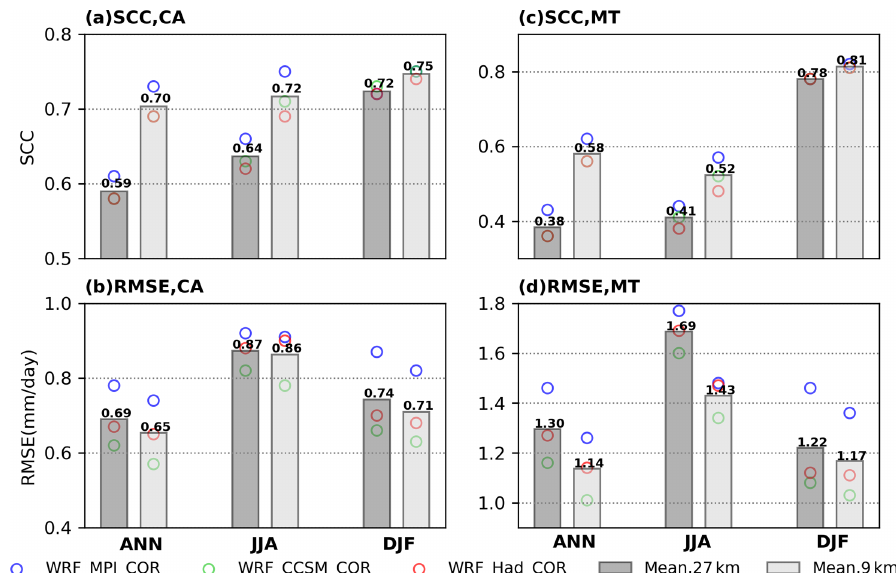
Figure 8. Spatial correlation coefficients (SCCs) and root mean square errors (RMSEs) of the simulated annual (ANN), summer (JJA: June– July–August), and winter (DJF: December–January–February) mean precipitation over CA and the mountainous areas (MT) in the 9 and 27km resolution downscaled results. The metrics are calculated based on 52 stations’ data across